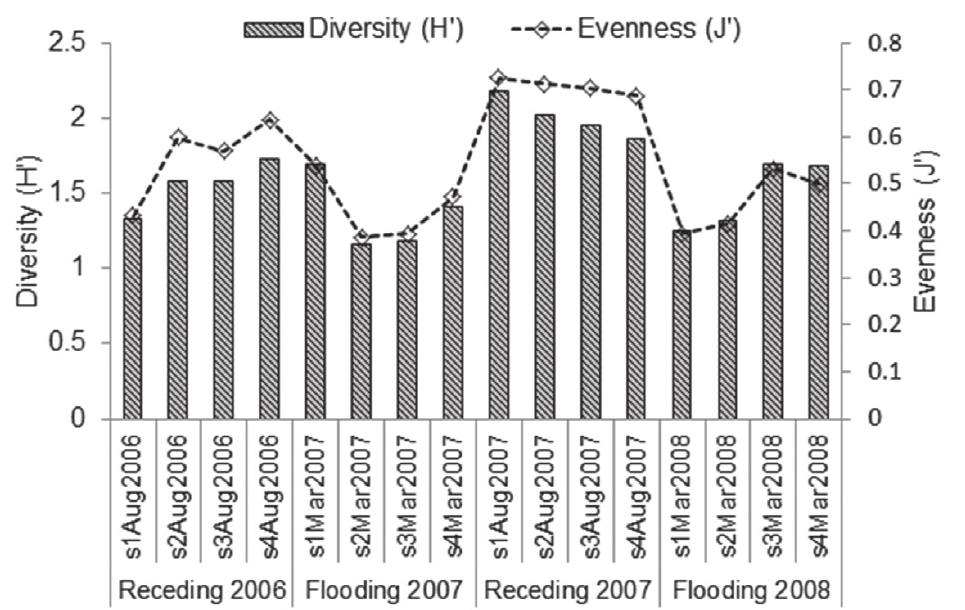
Figure 5 - Diversity (bars) and evenness (line) indexes of all sampling stations (s1, s2, s3 and s4) during the two consecutive hydrological cycles (August and